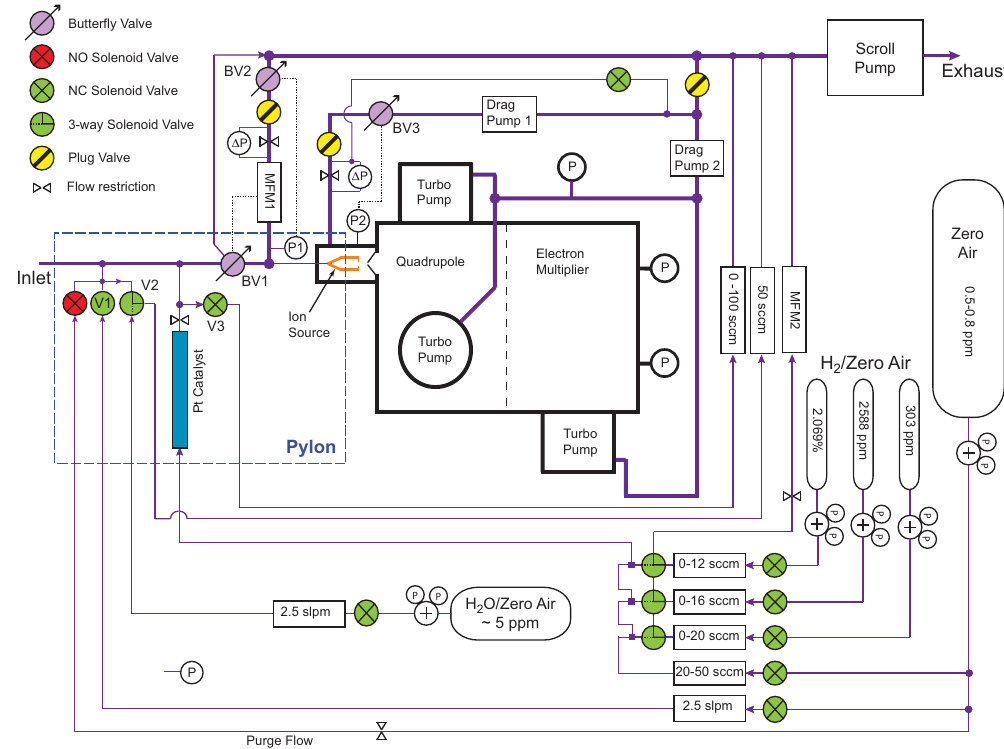
Fig. 1. Schematic of the CIMS instrument showing the principal components of the flow and calibration systems. A custom butterfly valve (BV1) controls the inlet sample mass flow measured by mass flow meter MFM1. BV2 regulates the main inlet pressure (P1), and BV3 regulates the ion source pressure (P2). Solenoid valve V1 is the zero air delivery valve, V2 is the H 2 O standard delivery valve, and V3 is the H 2 /Pt-H 2 O calibration diversion valve. Mass flow controller flows or flow ranges during operation are specified. NO and NC denote normally open and normally closed solenoid